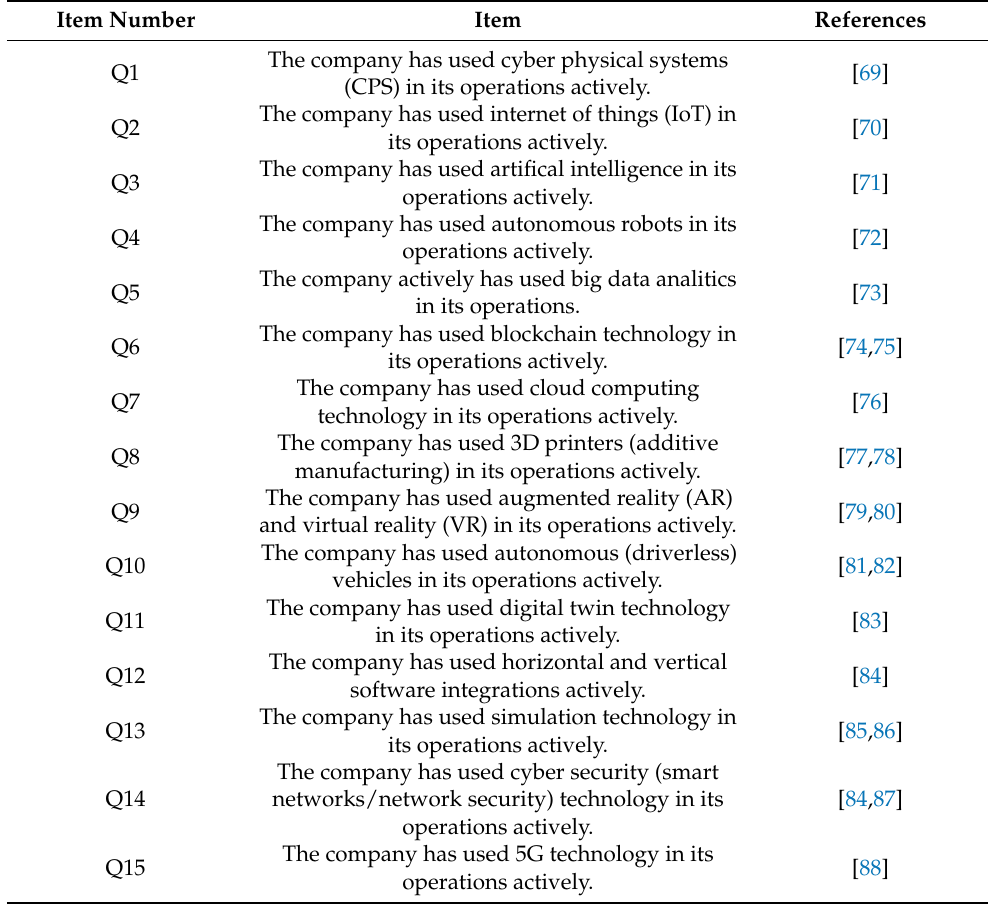
Table 5. Item Pool for the Main Study.